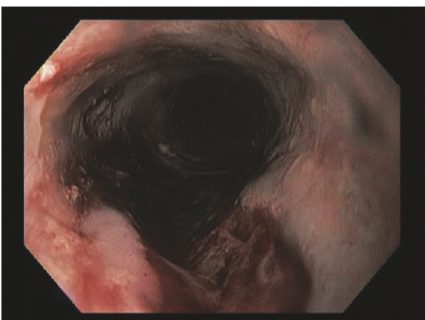
Figure 5: Esophageal squamous epithelium with H&E staining at 200x magnification with black arrow showing a Civatte body.